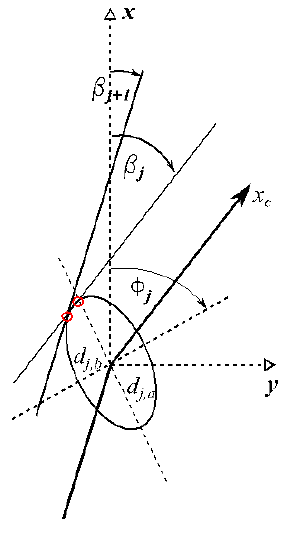
Figure 6. Construction of two tangent points to the j th error ellipse.